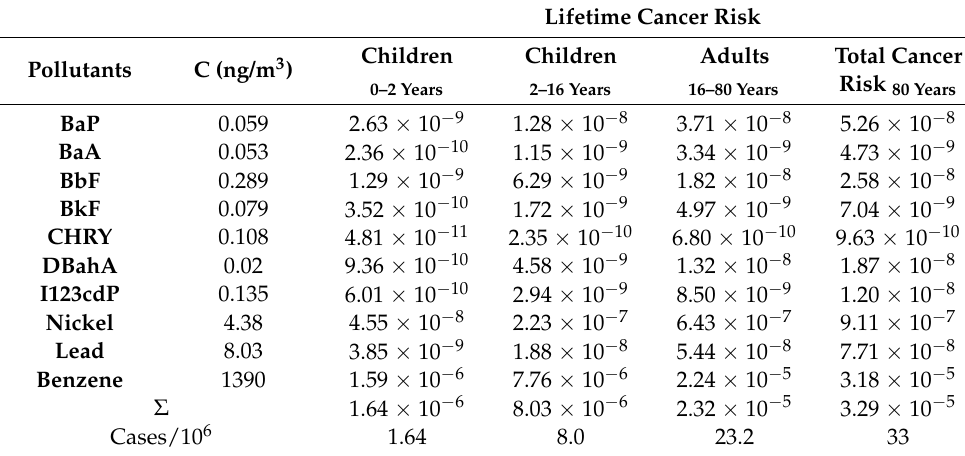
Table A5. Cancer risk assessment B.I method (OEHHA, 2015).